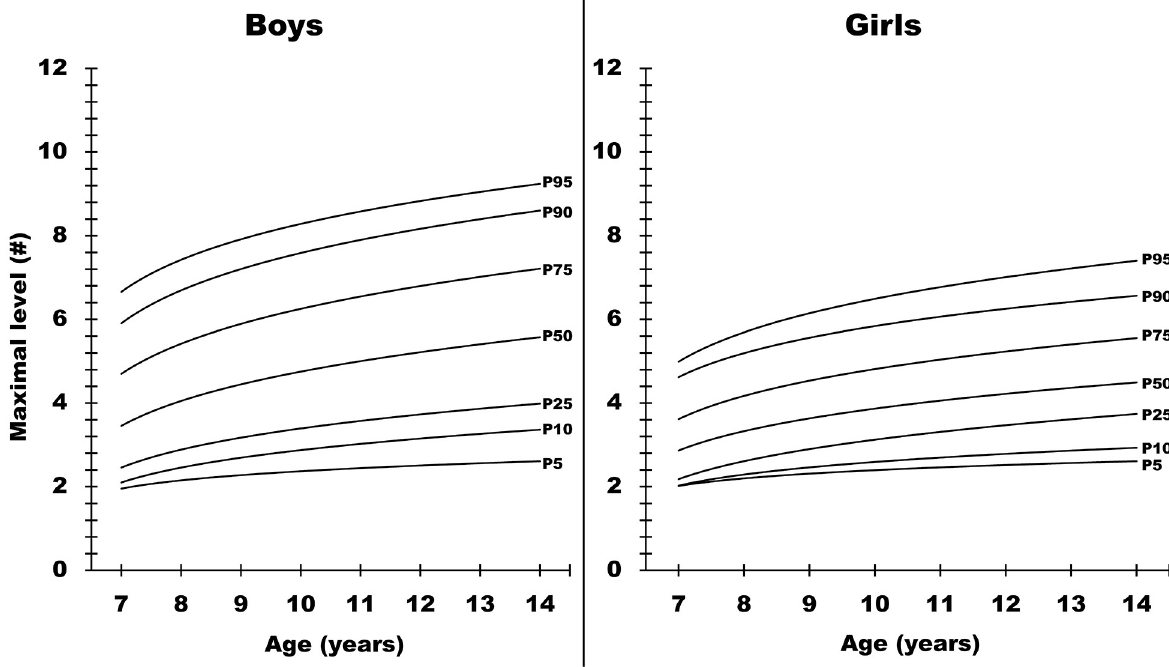
Fig 1. Graphical normative reference data for the maximal number of levels achieved after the 20-m shuttle run test, according to sex and age.